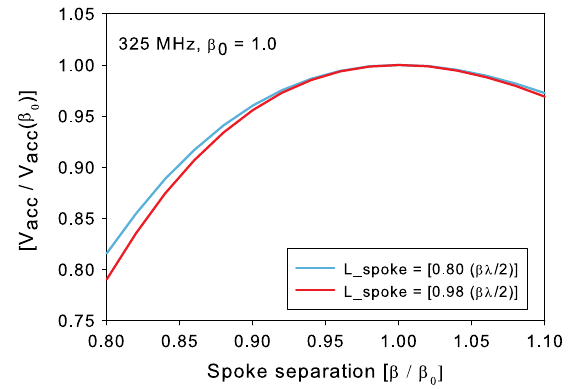
FIG. 28. Dependence of the normalized magnetic field and RR s on the parameter H.